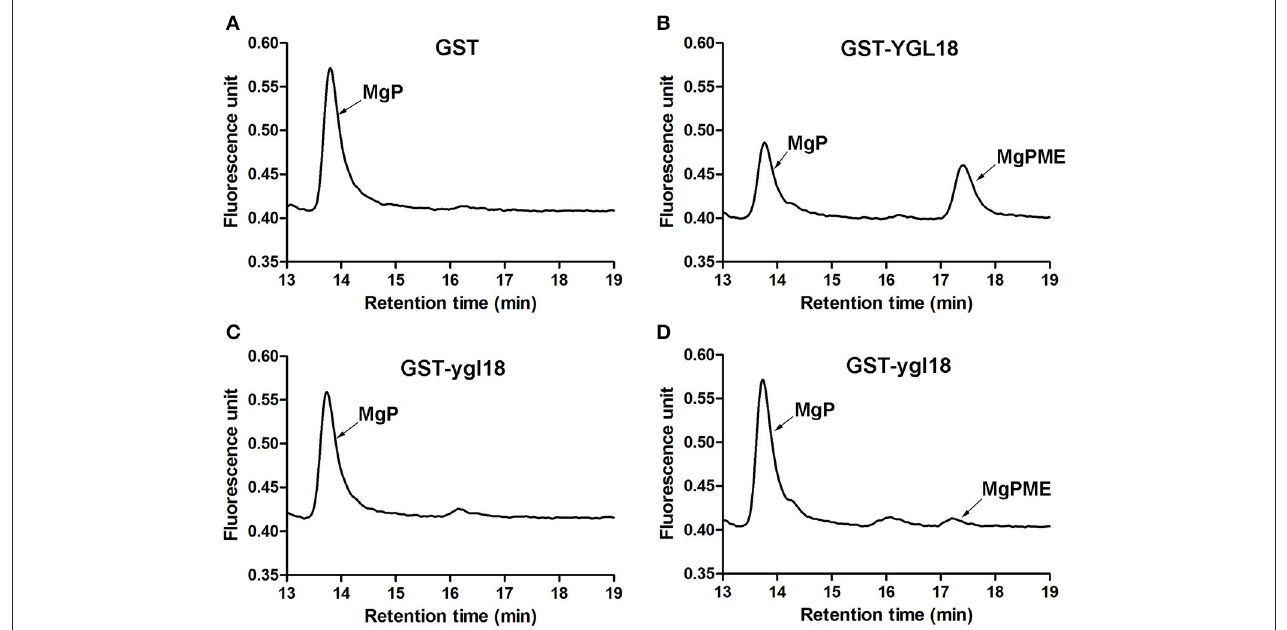
FIGURE 6 | ChlM enzymatic activities of YGL18 and ygl18 based on HPLC. The enzymatic assays were conducted by adding different purified proteins: (A) GST (0.6 µ M); (B) GST-YGL18 (0.6 µ M); (C) GST-ygl18 (0.6 µ M); (D) GST-ygl18 (2.4 µ M). The arrows indicate the peak positions of the substrate MgP (about 13.7 min) and the product MgPME (about 17.3 min), which are distinguished by comparing with the standard curve (Figure S2). Different letters indicate values are statistically different based on a one-way ANOVA